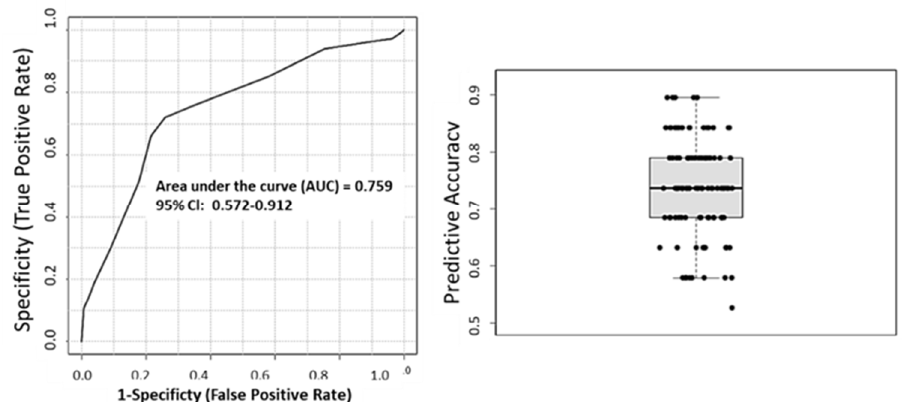
Figure 9. Multivariate ROC curve of differentially abundant lipids. Using a PLS-DA algorithm with 2 latent variables and 5 clusters the AUC is 0.759 and predictive accuracy of 73.7% based on 100 cross validations.